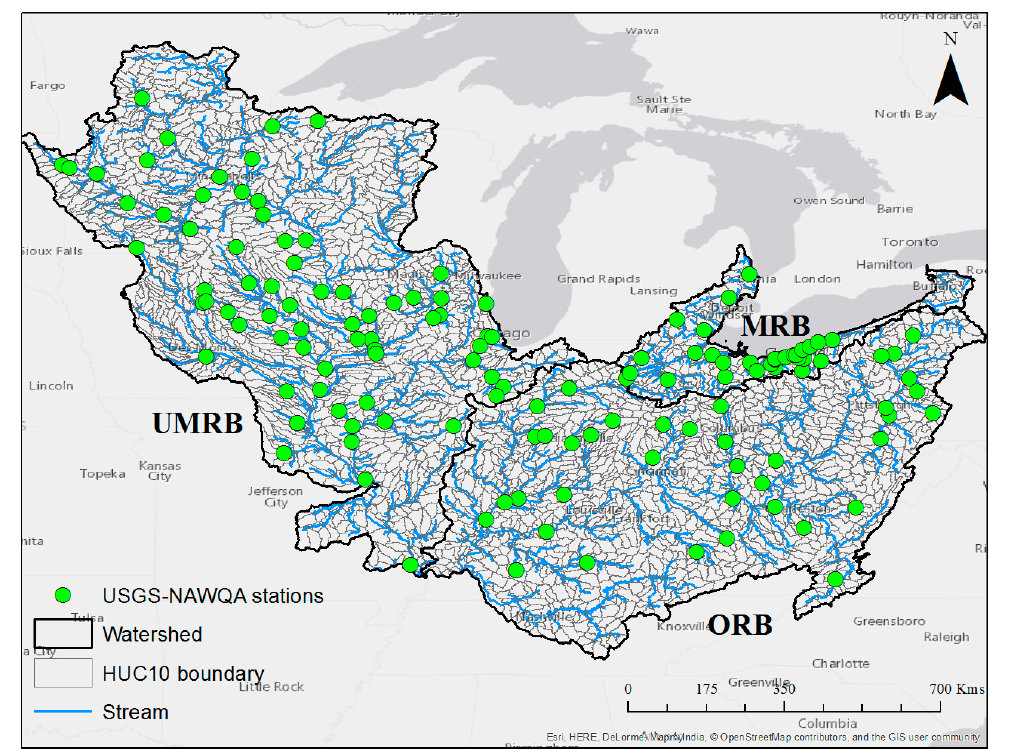
Figure 1. Study area consists of the Upper Mississippi River Basin, the Ohio River Basin, and the Maumee River Basin. Green circular markers denote the geographic location of USGS-NAWQA sta- tions, where data for water quality constituents such as suspended sediment concentration, nitro- gen, and phosphorus are